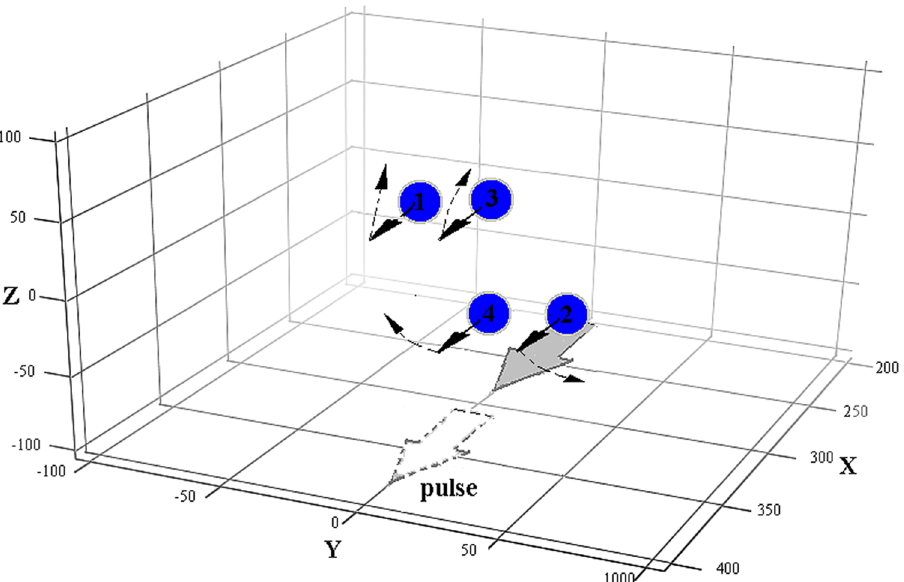
Figure 3. The positions of the four clusters in the simulation box. The X, Y and Z coordinates are given in nanometers. The laser pulse is circularly polarized and propagates along the x-axis. Pulse positions during interaction are shown by gray solid arrow and after by dash arrow. The solid arrows show the directionalities of cluster magnetic moments during laser pulse action. The dash arrows show the directions of magnetic moment rotation because magneto-dipole interaction after finishing of laser